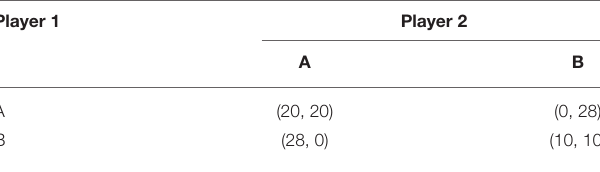
TABLE 2 | Payoffs of the one-shot